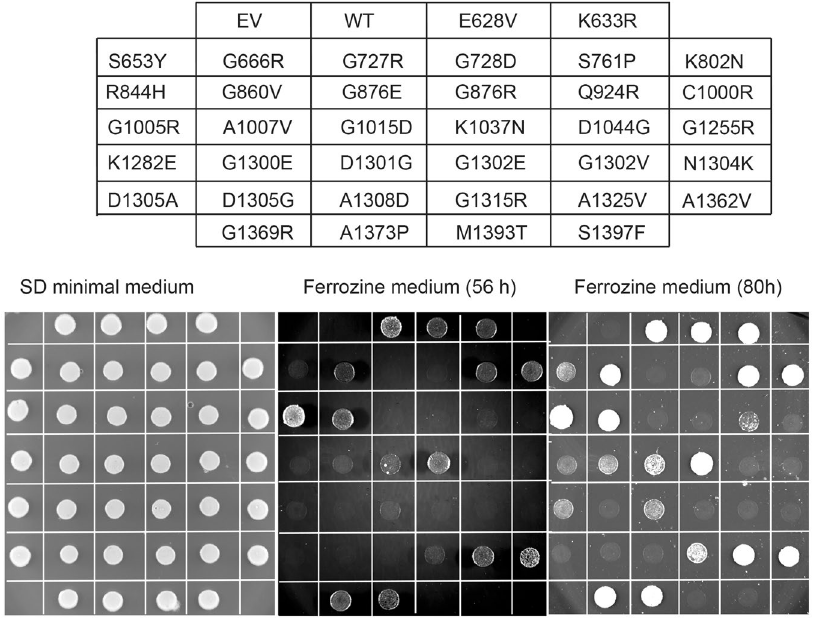
Figure 8. Complementation of the ccc2 Δ iron requiring phenotype on agar plates. All 36 variants were agar plates containing the iron chelator Ferrozine. WT, ccc2 Δ yeast cells producing wild-type ATP7A; EV, ccc2 Δ yeast cells expressing no ATP7A (empty vector). Mutants are spotted according to their amino acid substitution. To control for cell viability, each yeast strain was also spotted on iron-containing agar